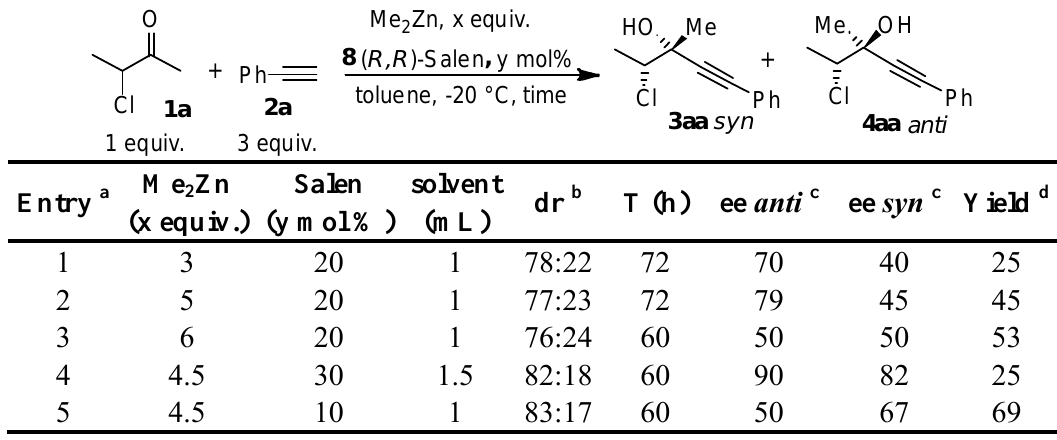
Table 2. Stereoselective addition of phenylacetylene to 3-chlorobutanone promoted by ( R,R )-Salen